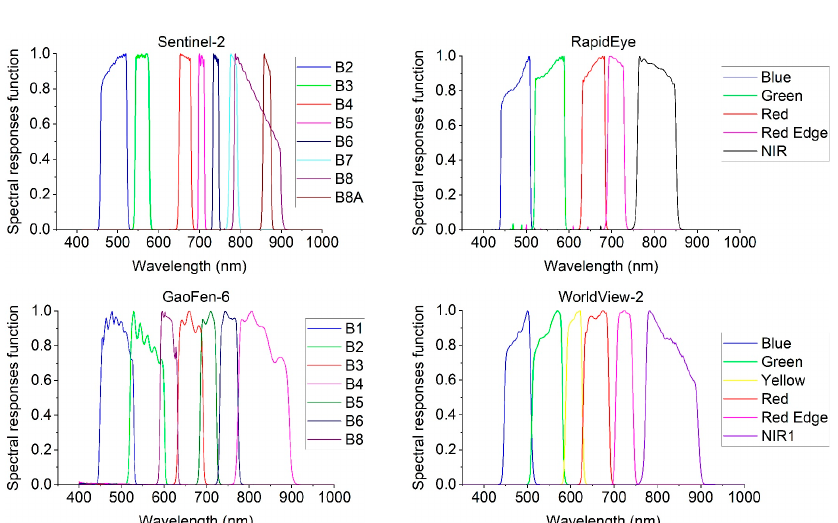
Figure A1. Spectral response functions of satellite sensors used for simulation of broadband reflec ‐ tance.